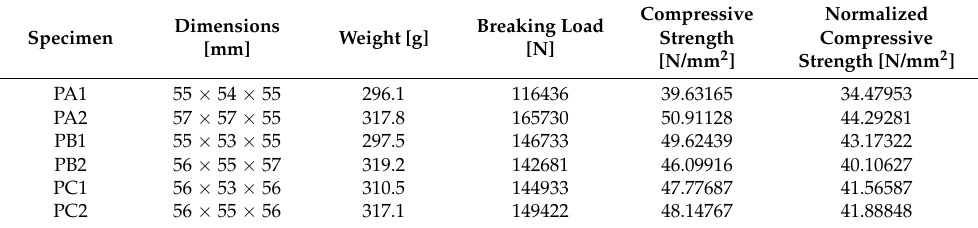
Figure 31. The six specimens tested for brick characterization: ( a ) before the test, ( b ) after the test. Table 1. Geometric and mechanical characteristics of the six brick specimens.